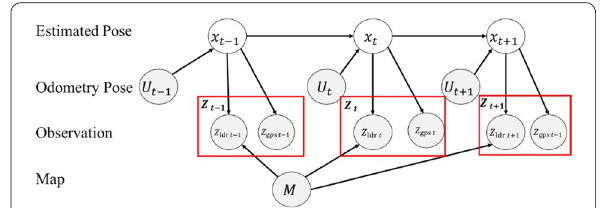
Fig. 2 Graphical model of SLAM based on GPS and